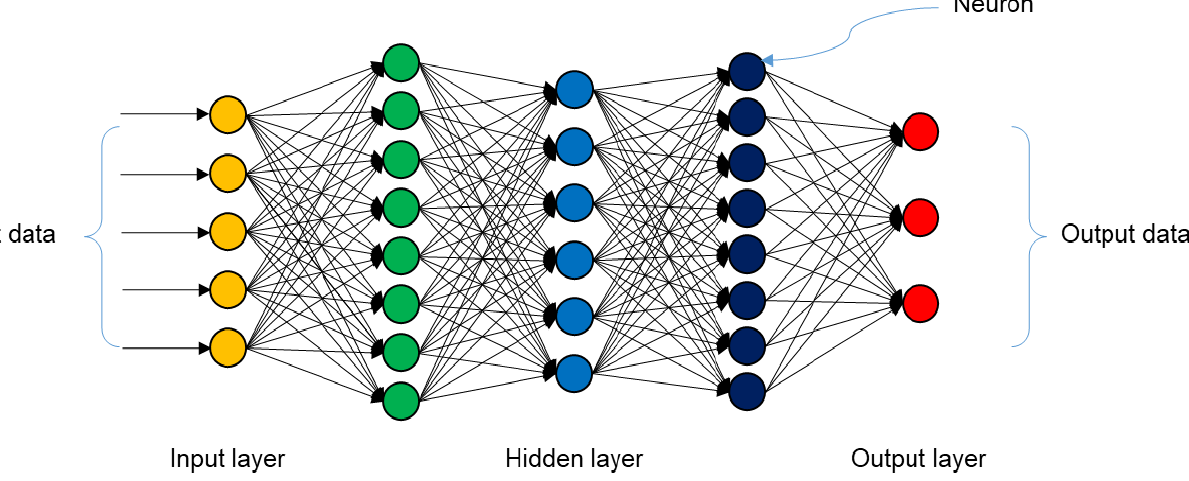
Figure 5. Conceptual diagram of the deep neural network.